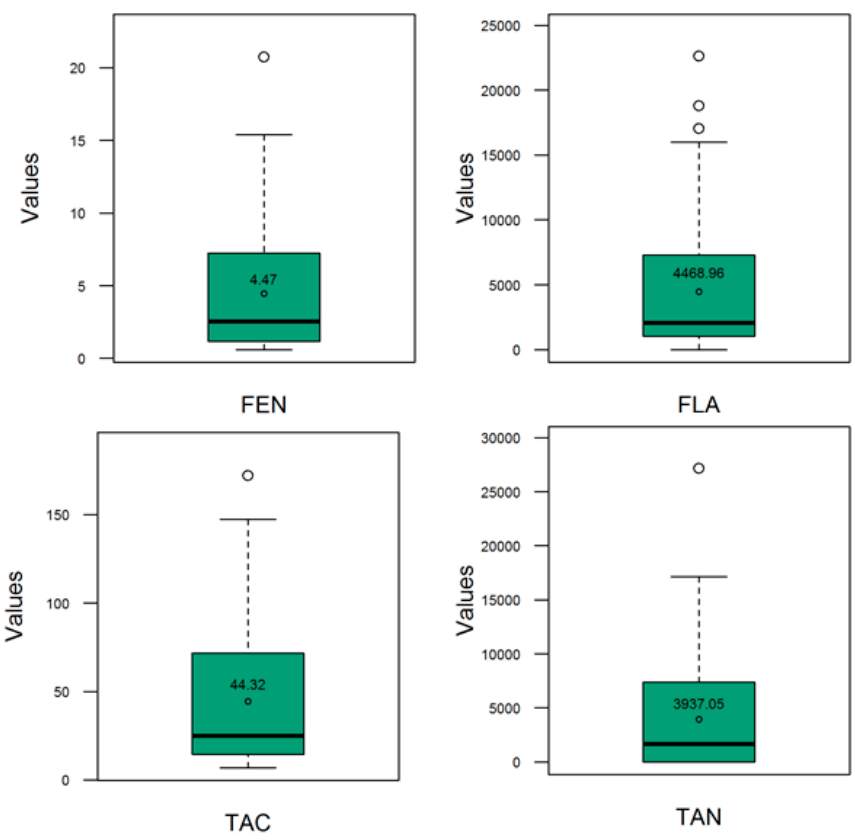
Figure 1. Distribution (boxplot) of polyphenol (FEN), flavonoids (FLA), condensed tannins (TAN), and total antioxidant concentrations. The open dot and the numbers inside the green rectangles (interquartile ranges) represent, respectively, the position of mean and the mean of the trait of intertest. The horizontal bar inside the green rectangles represents the median of the trait of interest. Refer to text for the description of the traits.